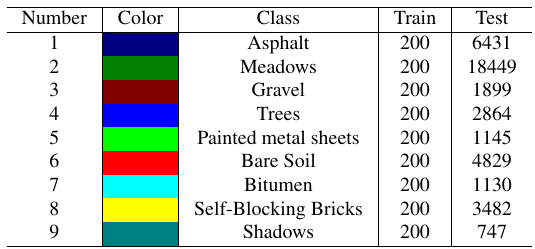
Table 1. Pavia University dataset with train and test sample size per